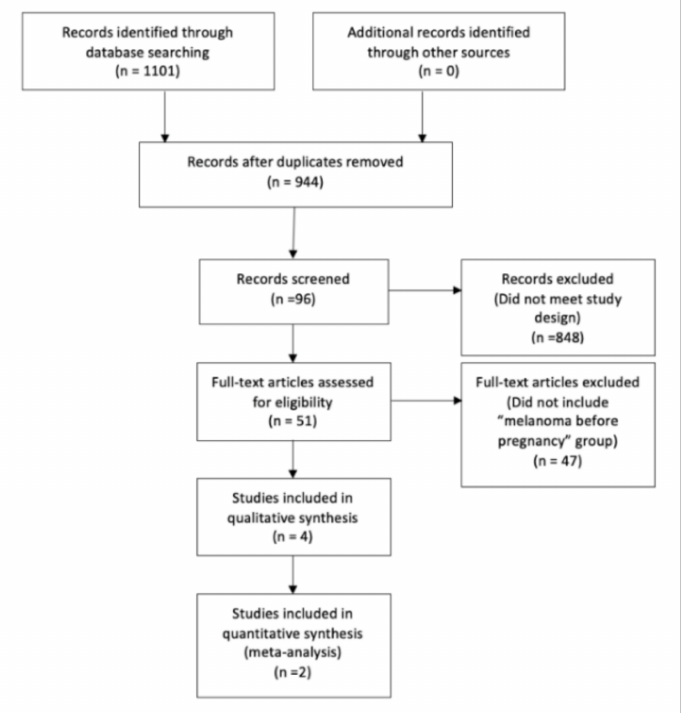
Figure 1. Flowchart of search strategy.